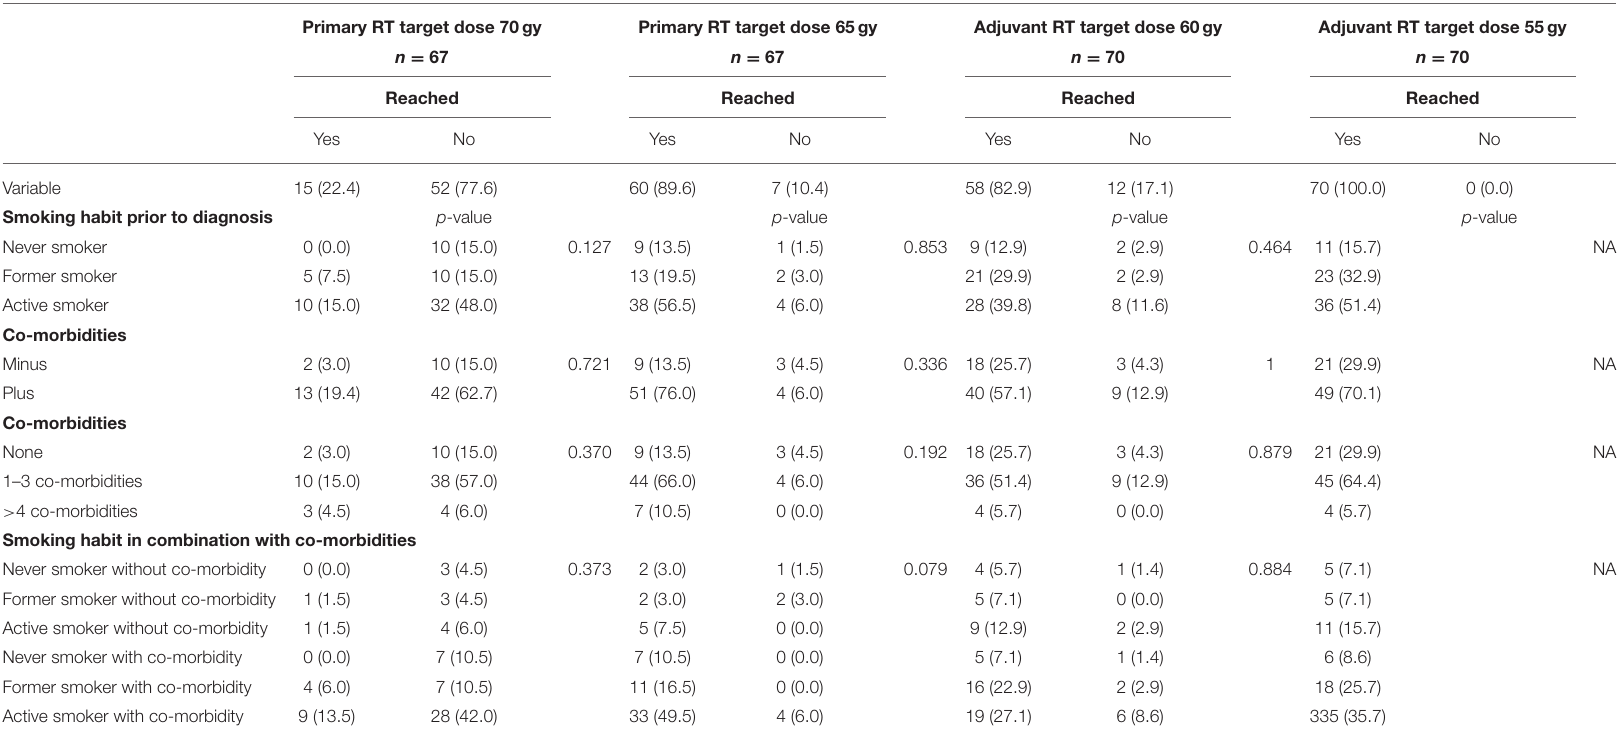
B: Reaching the target dose of either primary or adjuvant RT during RCT treatment. In contrast to the cisplatin data radiotherapy data were available for all 137